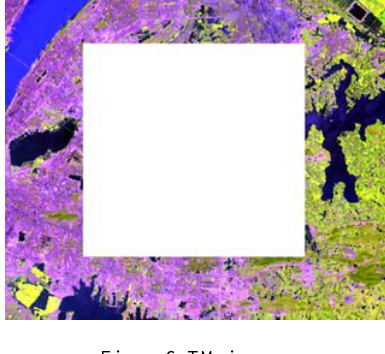
Figure 6. TM image